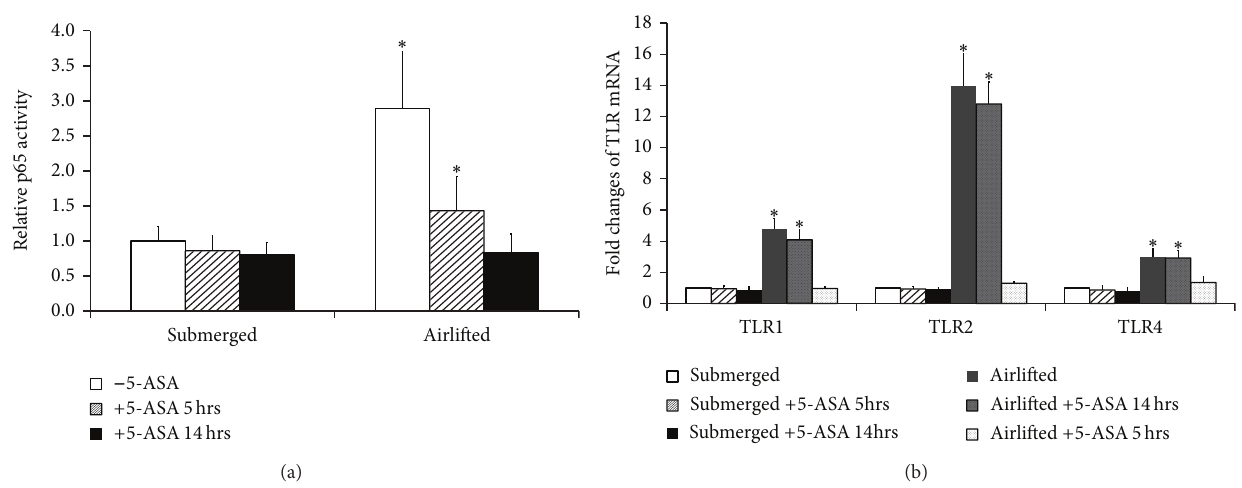
Figure 4: The effect of NF 𝜅 B inhibition on airlifted IOBA-NHC TLR expression. (a) Relative activity of p65 in submerged and airlifted IOBA-NHC cells with and without 5-ASA. p65 activity in submerged monolayer cells without 5-ASA was set as 1, and the activities of other cell conditions were compared to it. Asterisks ( ∗ ) denote significant difference ( 𝑃 < 0.05 ) between airlifted and submerged cells under the same treatment. (b) Fold changes of selective TLR mRNA expression by qPCR. Individual TLR expression in submerged monolayer cells without 5-ASA was used as control to calculate the fold change. Asterisks ( ∗ ) denote significant difference ( 𝑃 < 0.05 ) between airlifted and submerged cells under the same treatment. All experiments were repeated three times, and the data were averaged. 𝑌 error bars represent the standard deviation of the averaged